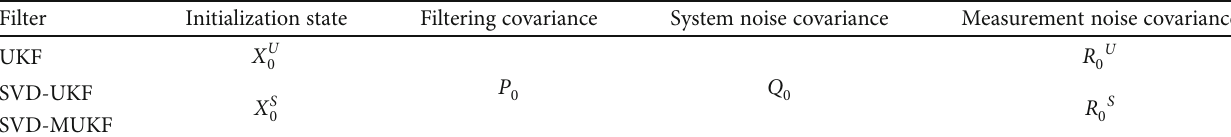
Table 1: Uniform motion fi lter initialization conditions.